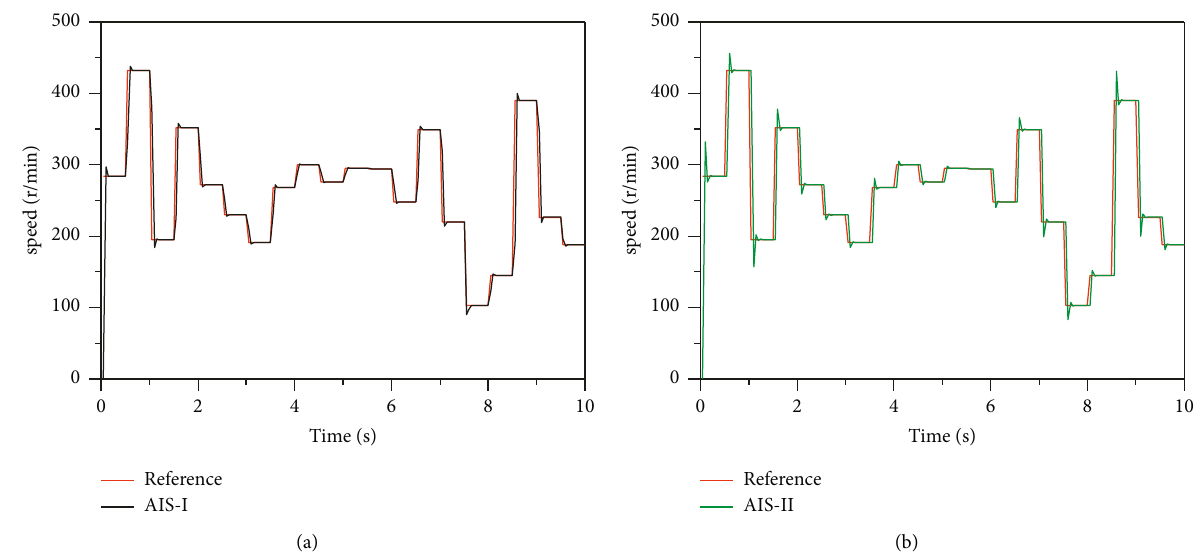
Figure 13: Simulated speed response: (a) speed response based on the AIS-I method and (b) speed response based on AIS-II